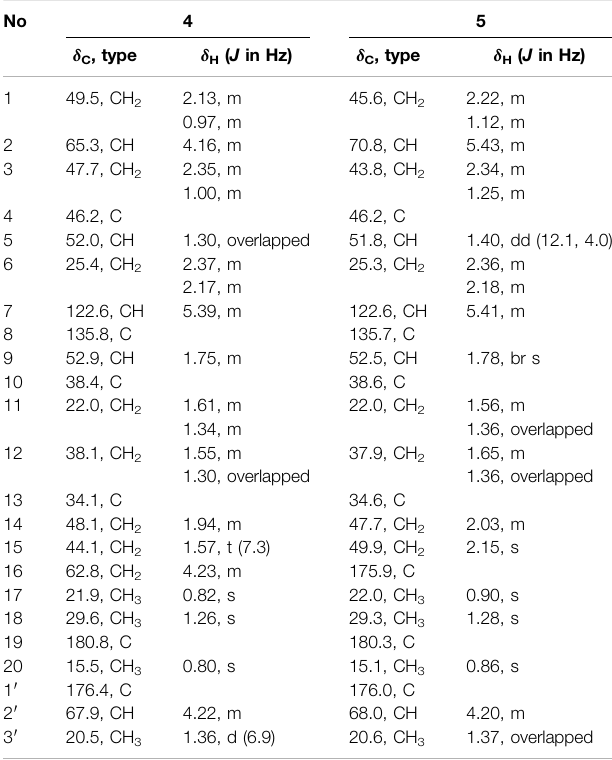
TABLE 2 | 1 H NMR (500 MHz) and 13 C NMR (125 MHz) spectroscopic data for 4 and 5 (Methanol- d 4 ).